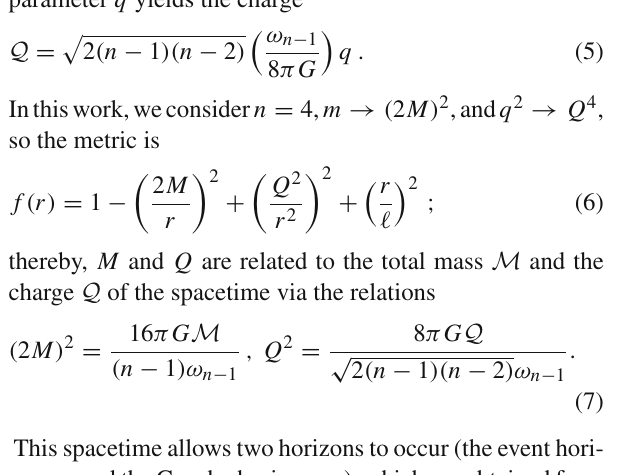
In Fig. 1, the blue line corresponds to the case Q = 0, and